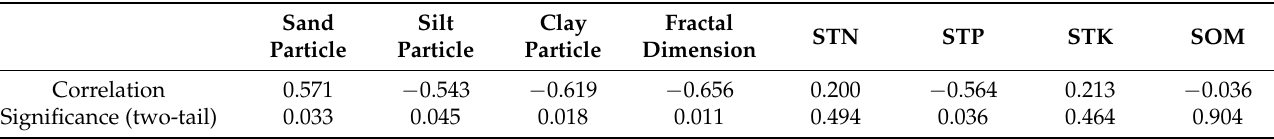
Figure 5. Correlation between soil erodibility and soil physicochemical properties under different hedgerow patterns. * p < 0.05. Table 3. Partial correlation between soil erodibility and soil physicochemical properties under different hedgerow